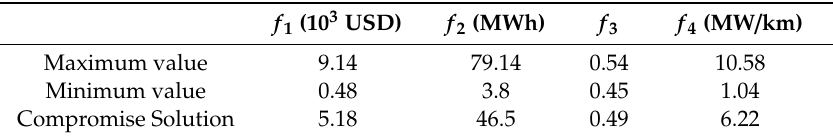
Table 3. The value of each objective function.